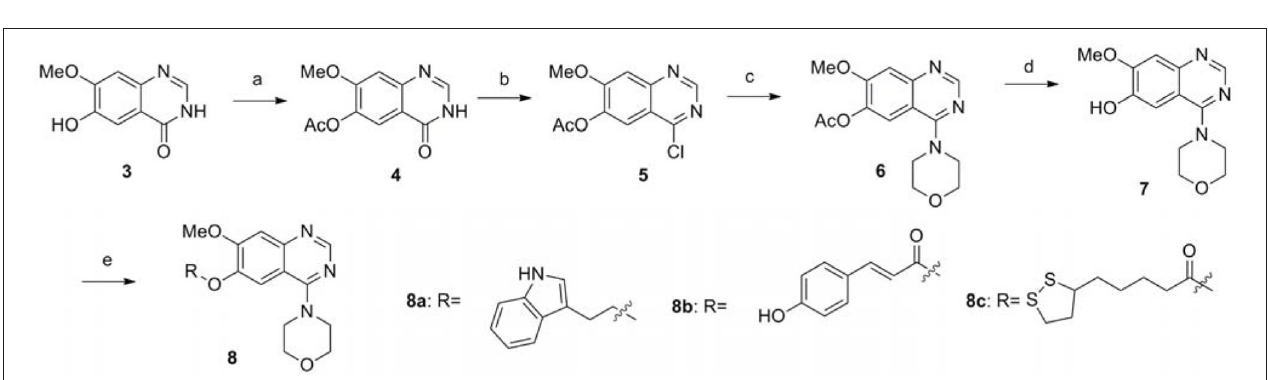
SCHEME 1 | The synthesis route of compounds 8a − 8c . Reagents and conditions: (a) Aceticanhydride, pyridine, 100 ◦ C, 2h; (b)SOCl 2 , DMF, 80 ◦ C, 2.5h; (c) Morpholine, DMF, 80 ◦ C, 6h; (d) Ammonia, methanol, reflux, 2h; (e) The corresponding bromide, K 2 CO 3 , DMF, reflux for 3h; or the corresponding acid, EDCI, DMAP, DMF, reflux